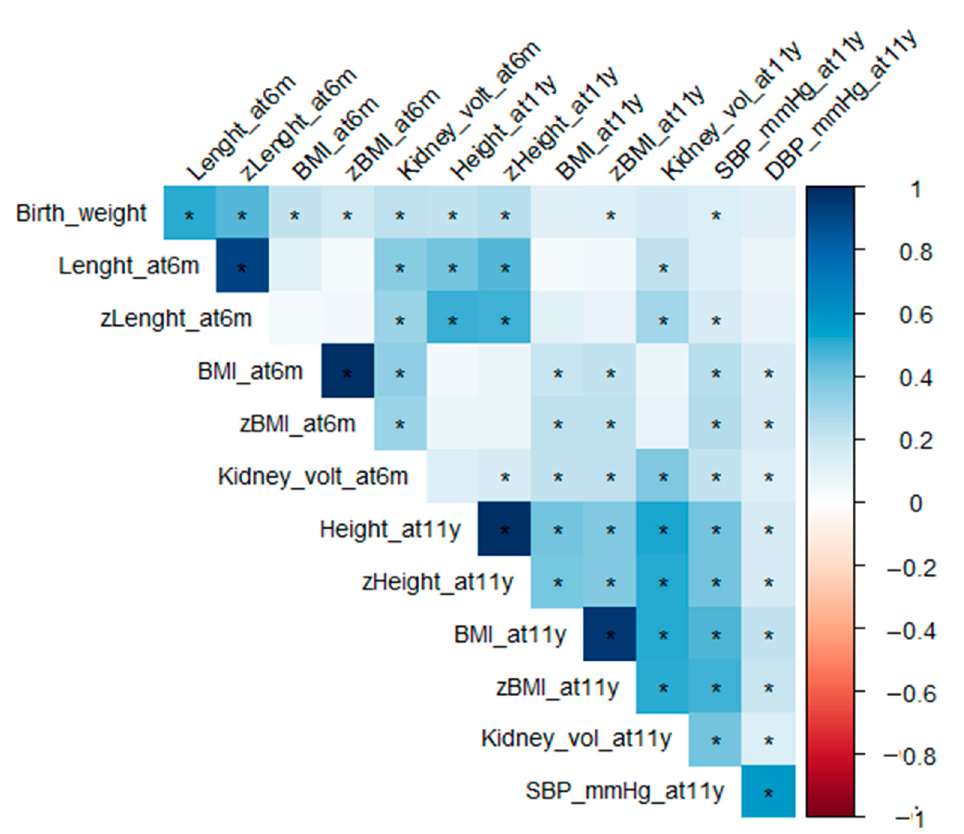
For continuous variables, mean (SD) for categorical variables a , N (%). p -values between specified groups: * p < 0.05 and ** p < 0.01 vs. breastfeeding. † p < 0.05 vs. low protein. The correlation between variables is shown in Figure 1.